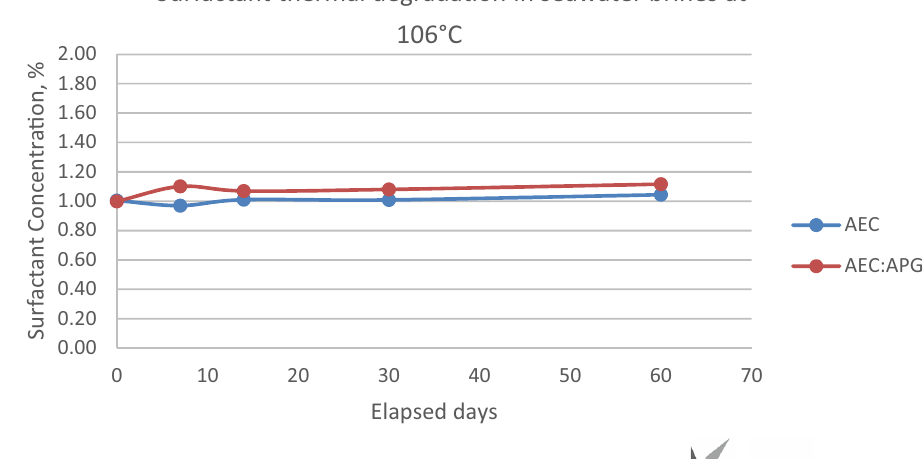
Fig. 14 Surfactant thermal deg- radation at 106 °C in seawater salinity brine